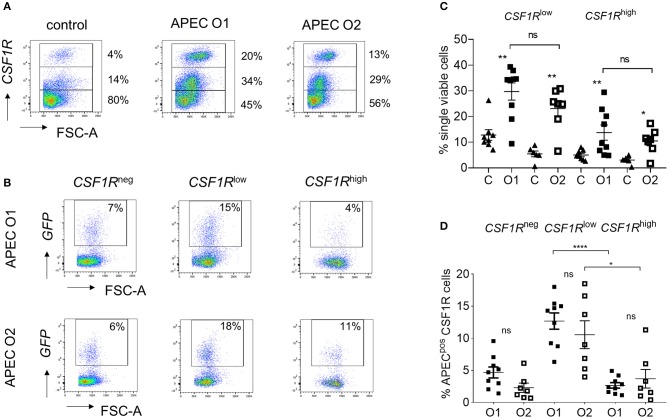
Flow cytometric analysis of single, live lung cells from APEC inoculated birds. Gradient purified lung cells were isolated and subjected to flow cytometric analysis to detect APECpos cells. (A) Representative plots showing the increase of CSF1R-tghigh and CSF1R-tglow cell numbers within 6 hpi, (B) quantification of the increase of CSF1R-tghigh and CSF1R-tglow cell numbers amongst all birds, (C) representative plots showing the APECpos cells in CSF1-tgneg, CSF1R-tglow, and CSF1R-tghigh cells of a representative APEC O1-GFP and APEC O2-GFP inoculated bird and (D) quantification of the APECpos cells in CSF1R-tgneg, CSF1R-tglow, and CSF1R-tghigh cells amongst all birds. O1 is APEC O1-GFP, O2 is APEC O2-GFP. n = 9 APEC O1-GFP, n = 7 APEC O2-GFP. The mean with SEM is shown. *P < 0.05, **P < 0.01, ****P < 0.0001.